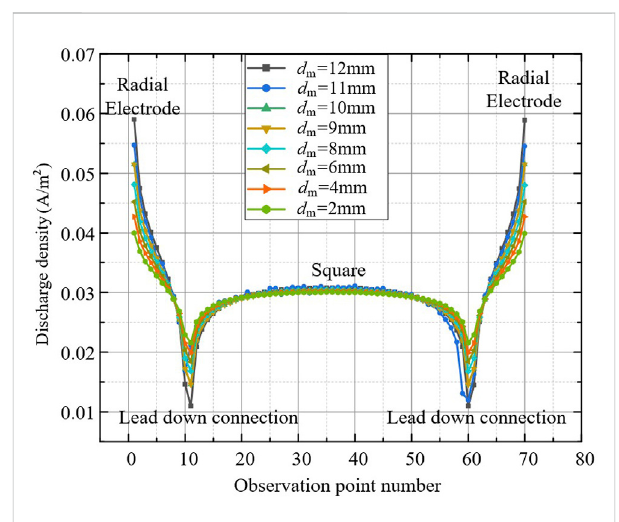
FIGURE 2 The power-frequency discharge characteristics of corroded grounding